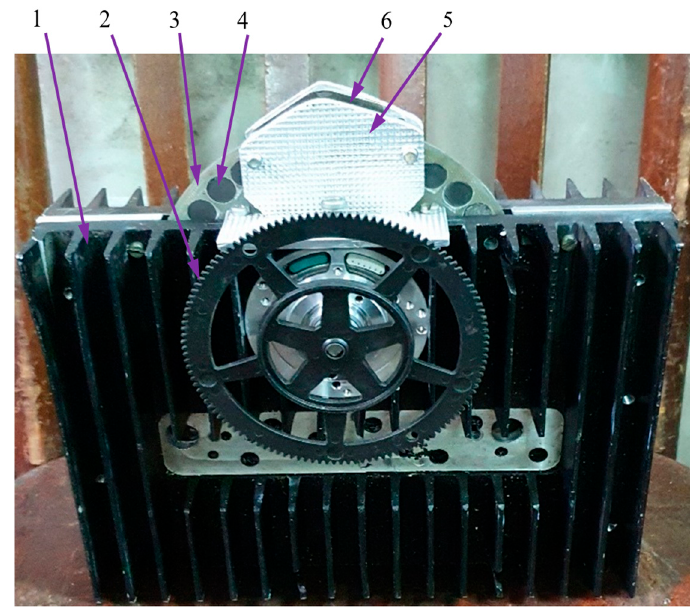
Figure 2. Gadolinium motor overview: 1—aluminum radiator; 2—sprocket for taking mechanical power; 3—disk-shaped rotor; 4—gadolinium pills; 5—permanent magnets; 6—permanent magnet holder [1].